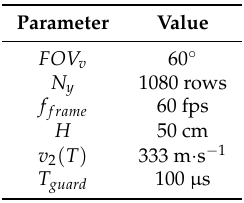
Table 2. Baseline parameters of the simulation.